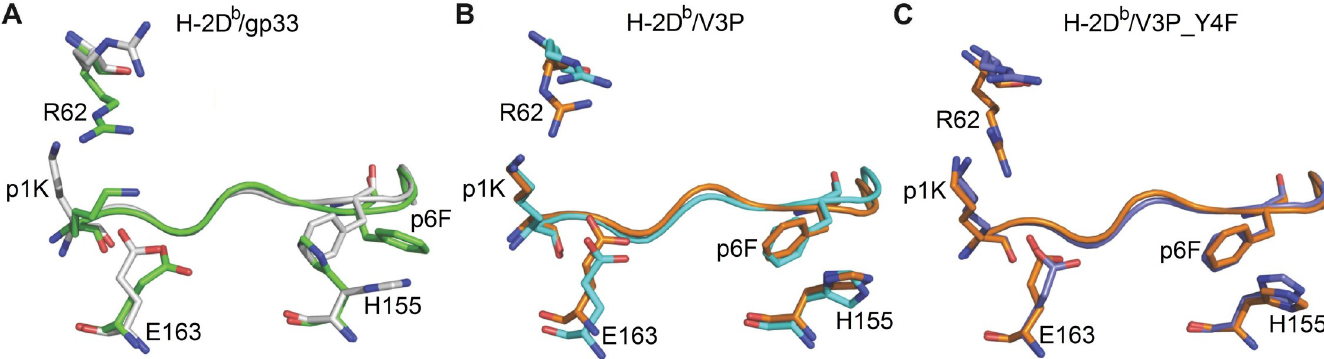
Fig 5. The p3P modification affects the conformations of peptide residues p1K and P6F, as well as H-2D b residues R62, H155 and E163 facilitating TCR recognition. A. Comparison of H-2D b /gp33 before (in green) and after P14 binding (in white) reveals that the conformation of a very limited amount of pMHC residues is affected (shown as sticks). Following binding to P14, the side chain of peptide residue p1K moves towards the N-terminal part of the peptide binding cleft while the side chain of p6F rotates. As a consequence, conformational changes are observed only for heavy chain residues R62, H155 and E163. B. In contrast to gp33, the introduced p3P modification already positions most peptide and heavy chain residues in optimal conformations, limiting significantly the required movements following binding to P14. pMHC residues before and after binding to P14 are colored orange and cyan. C. Similarly to V3P, the p3P modification in V3P_Y4F results in optimal positioning of all key peptide and heavy chain residues prior to binding to P14. pMHC residues before and after binding to P14 are colored orange and violet.